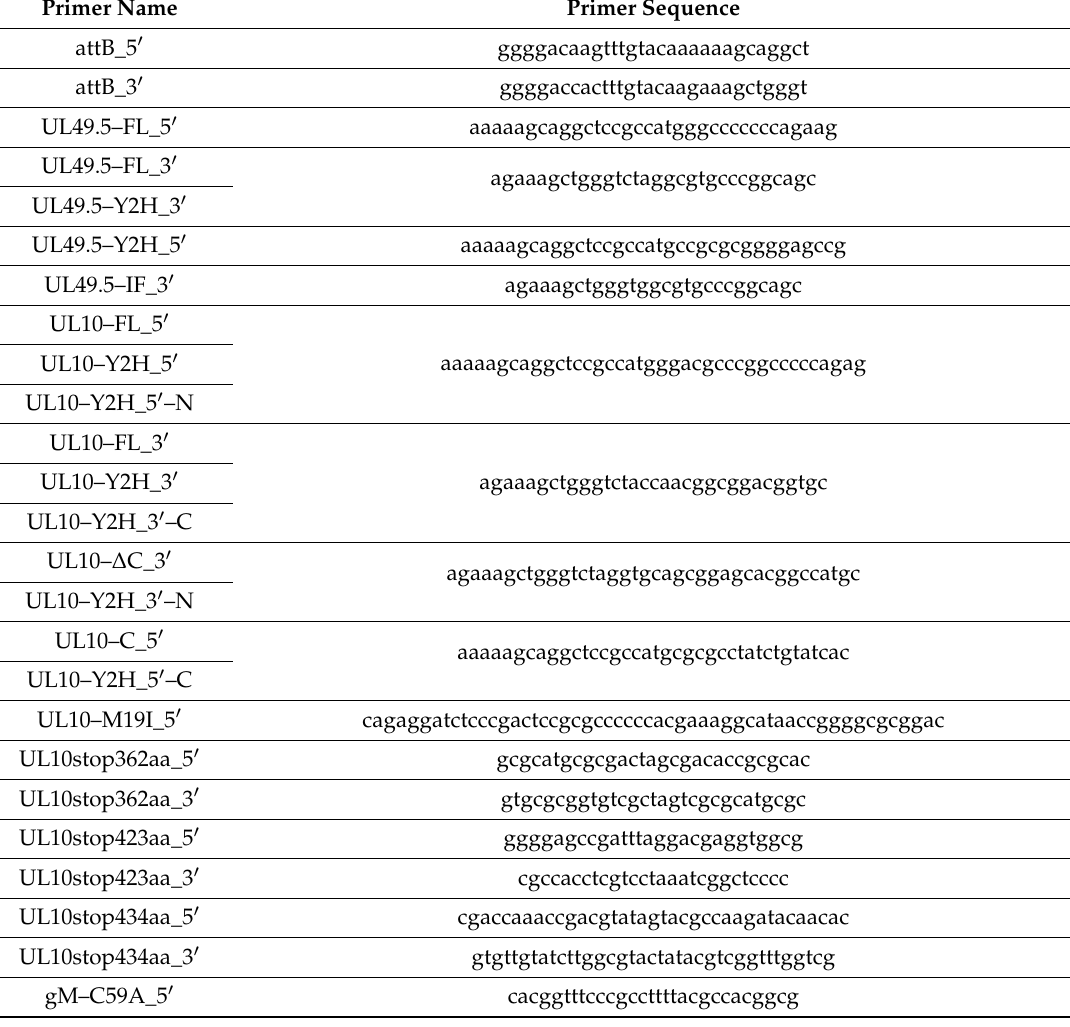
Table 1. Primer sequences used for plasmid cloning and BAC